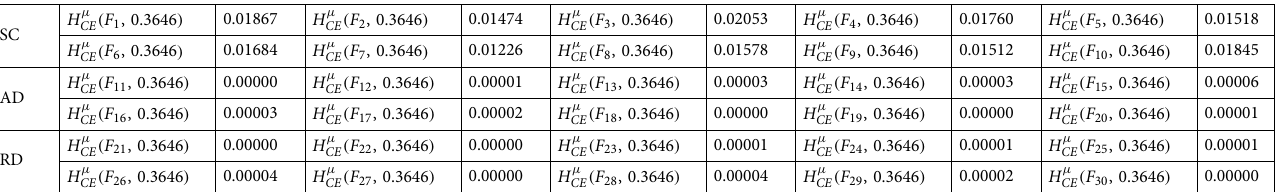
Table 6. Computation of FCE measure values between the fuzzy sets of various fault types in low frequency range.